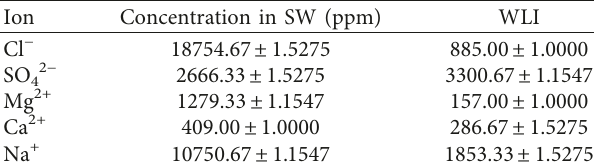
Figure 4: Compressive strength of all brands of OPC at w/c 0.7. Figure 2: Compressive strength at 2, 7, 14, and 28days for all Table 3: Results for analysis of SW and WLI in